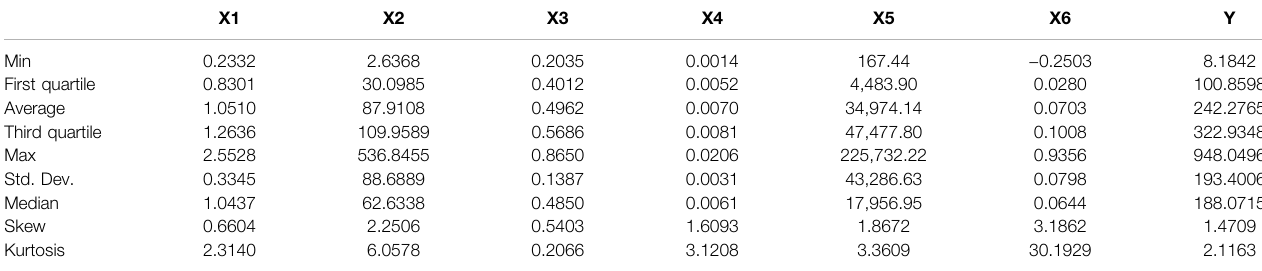
TABLE 1 | Descriptive statistics for original data between 2000 and 2015.